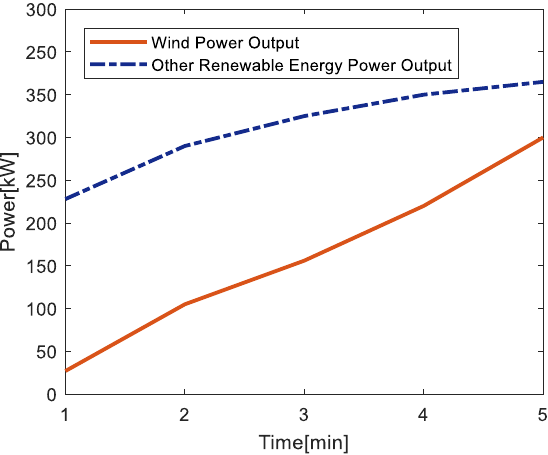
Figure 4. Wind farm power and its corresponding load conditions in period 4.